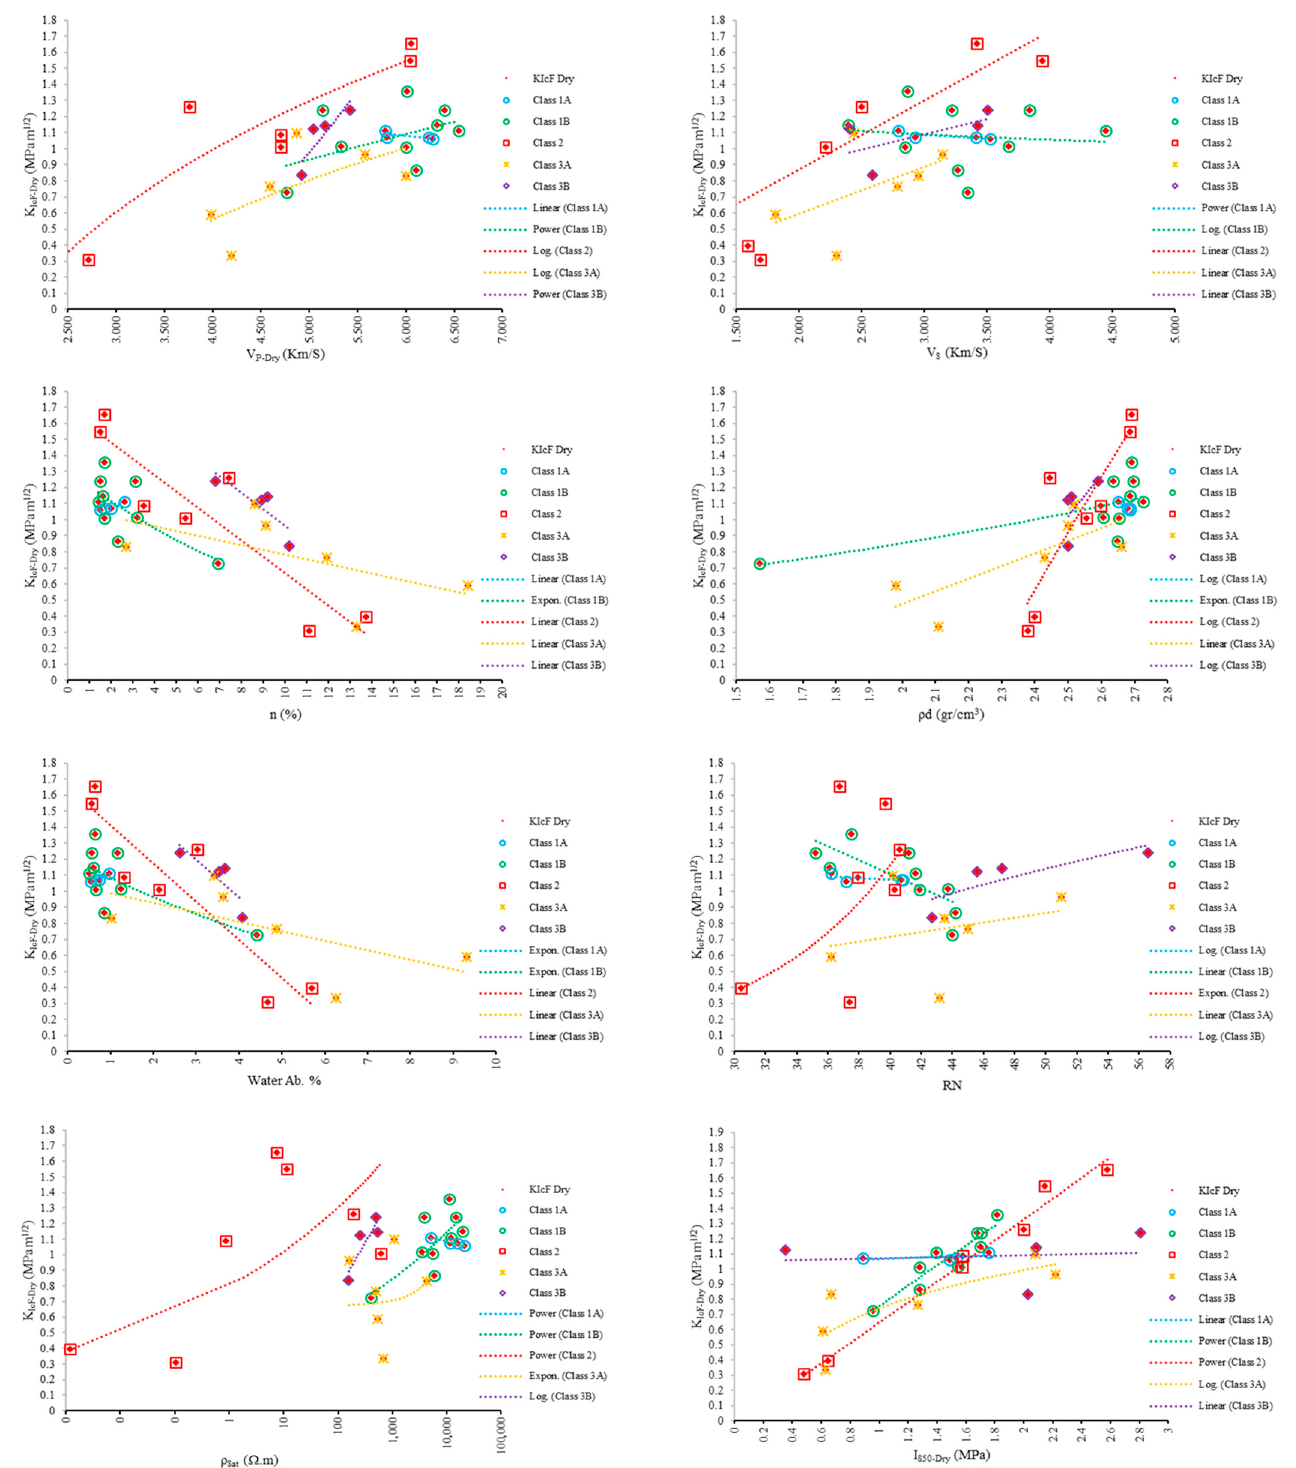
Figure 10. K IC versus different engineering properties for each petrographic class under a dry state.